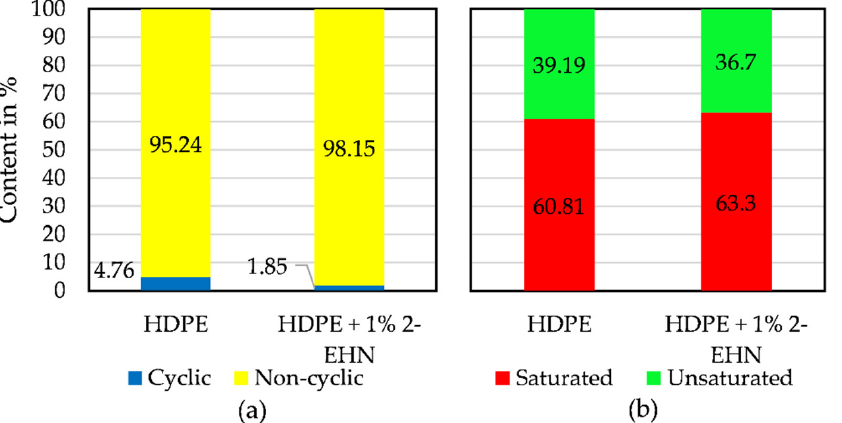
Figure 7. Content of ( a ) cyclic (blue) and non-cyclic (yellow) compounds and ( b ) the content of saturated (red) and unsaturated (green) compounds each in % of HDPE and of HDPE + 1% 2-EHN pyrolysis oils.